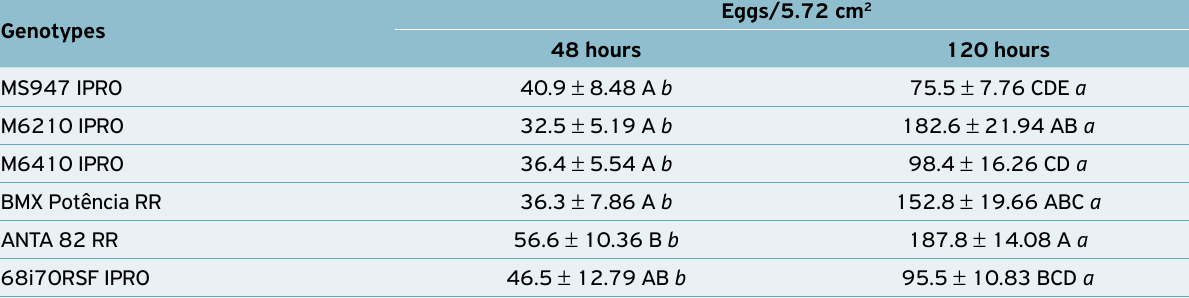
Table 3. Number (mean ± standard error) of eggs of Bemisia tabaci B biotype on six soybean genotypes, in two periods after infestation in non-choice tests, Dourados (MS), Brazil, 2016.